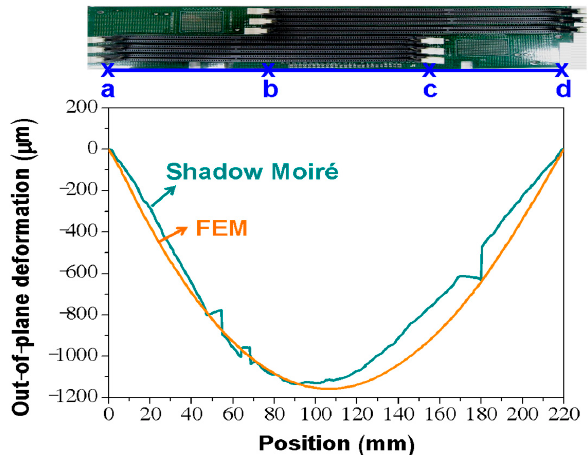
Figure 10. Full-field out-of-plane deformation ( W ) for the PCB assembly at room temperature after the solder reflow, obtained from the FEM simulation ( Δ T = − 220 °C).